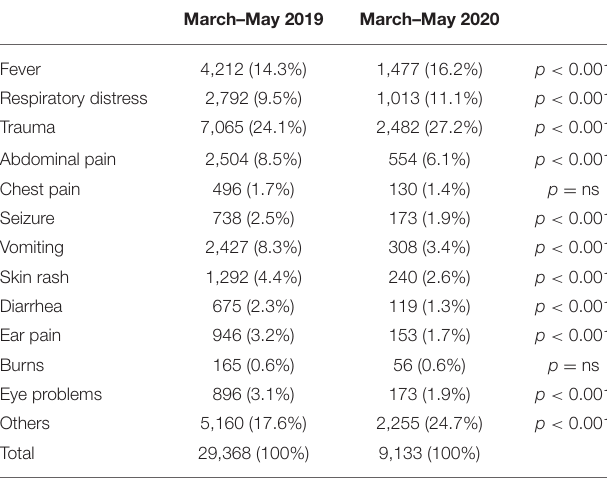
TABLE 2 | Main health problems prompting emergency department